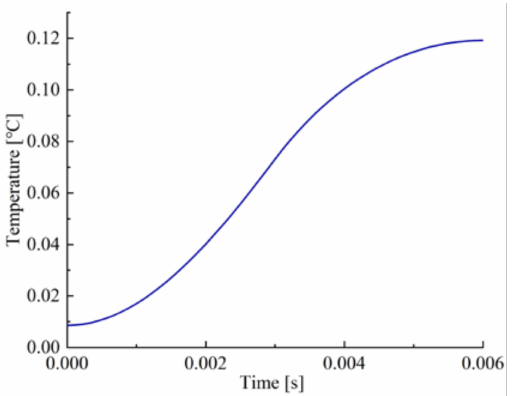
Figure 9. Variations in the temperature rise of the oil in the sealed cavity of the oil discharge